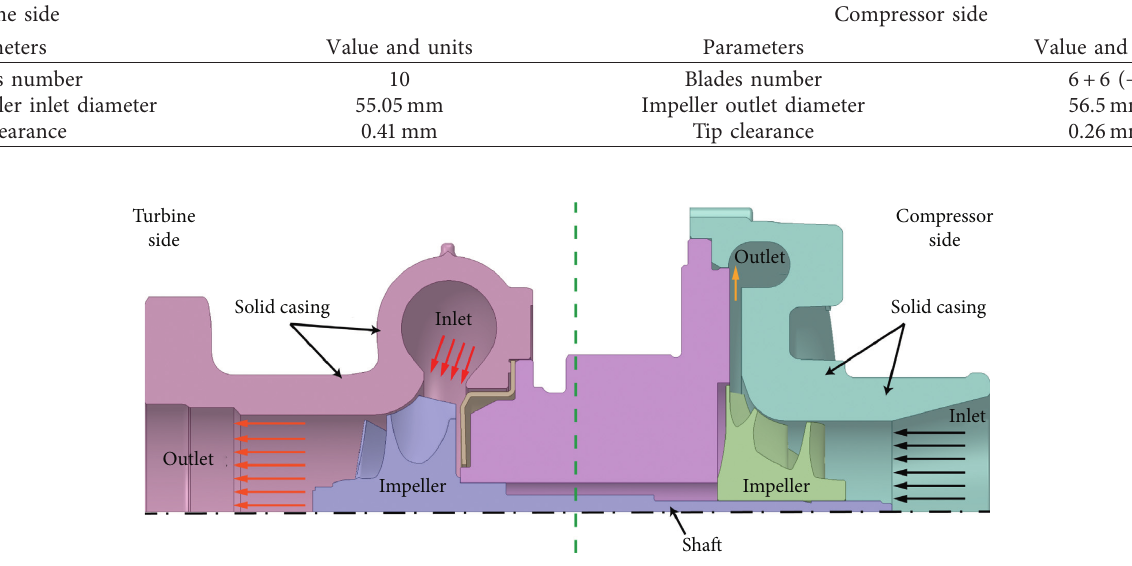
Figure 1: Centrifugal turbocharger and compressor with a solid casing.